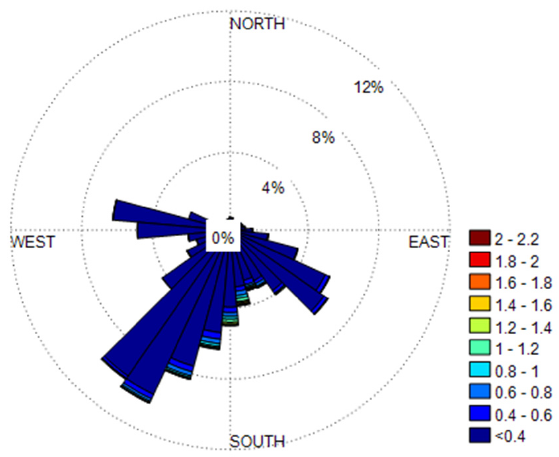
Figure 6. Wave rose for all wave measurements.